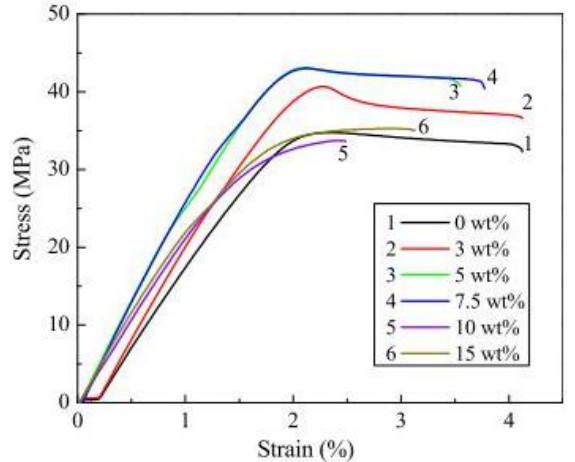
Figure 15. Typical tensile stress-strain curves for specimens with different carbon fiber contents. Reprinted with permission from [41], 2015, Elsevier, Amsterdam, The Netherlands.